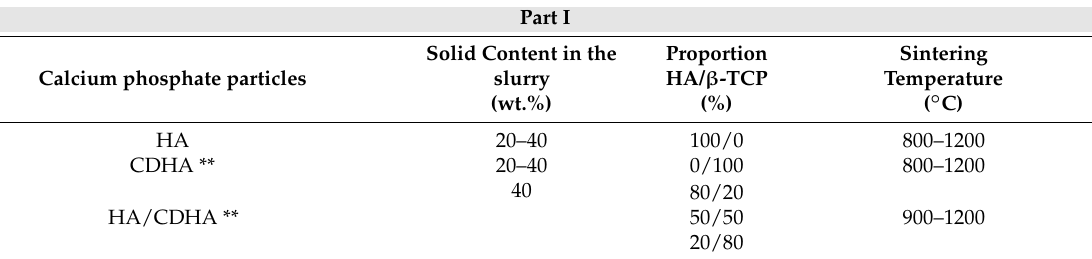
Table 2. Compositions of scaffolds fabricated from CaP nanoparticles